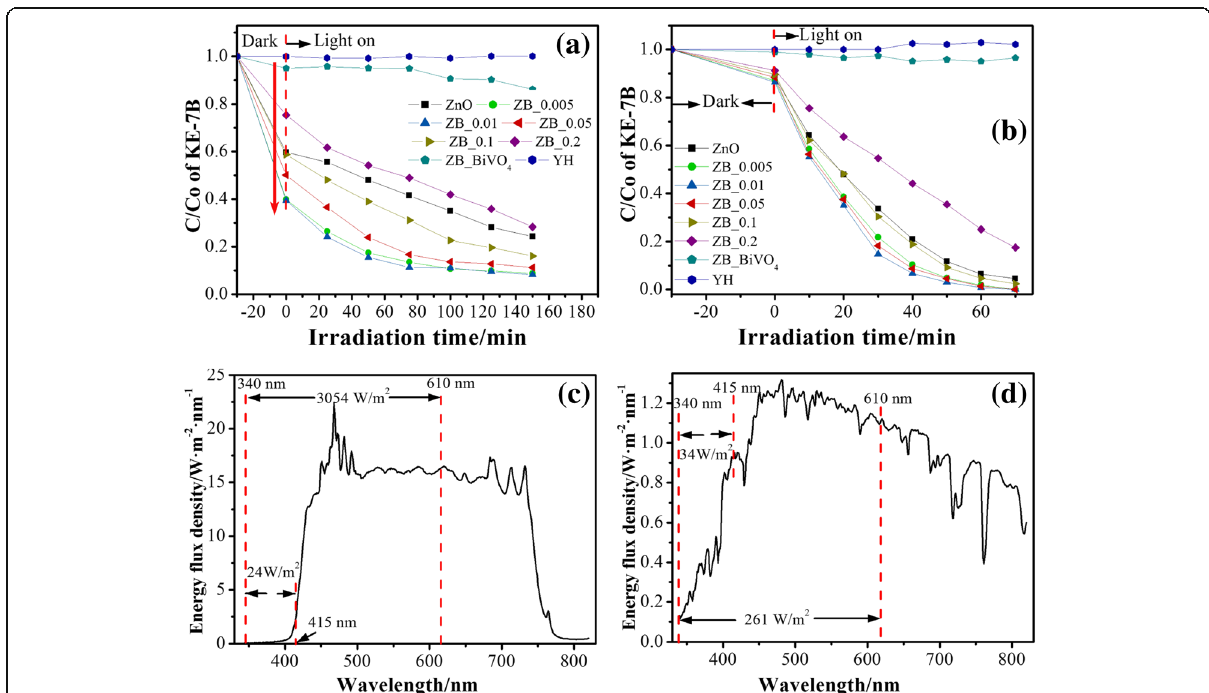
Fig. 8 Variation of the relative content of KE-7B (C/C 0 ) vs. irradiation time over ZnO, BiVO 4 , and BiVO 4 -modifying ZnO with different Bi/Zn molar ratios under visible-light ( a ) and natural sunlight ( b ) illumination. c Visible-light spectrum and ( d ) solar-light spectrum ranging 340~820nm measured by a movable spectroradiometer